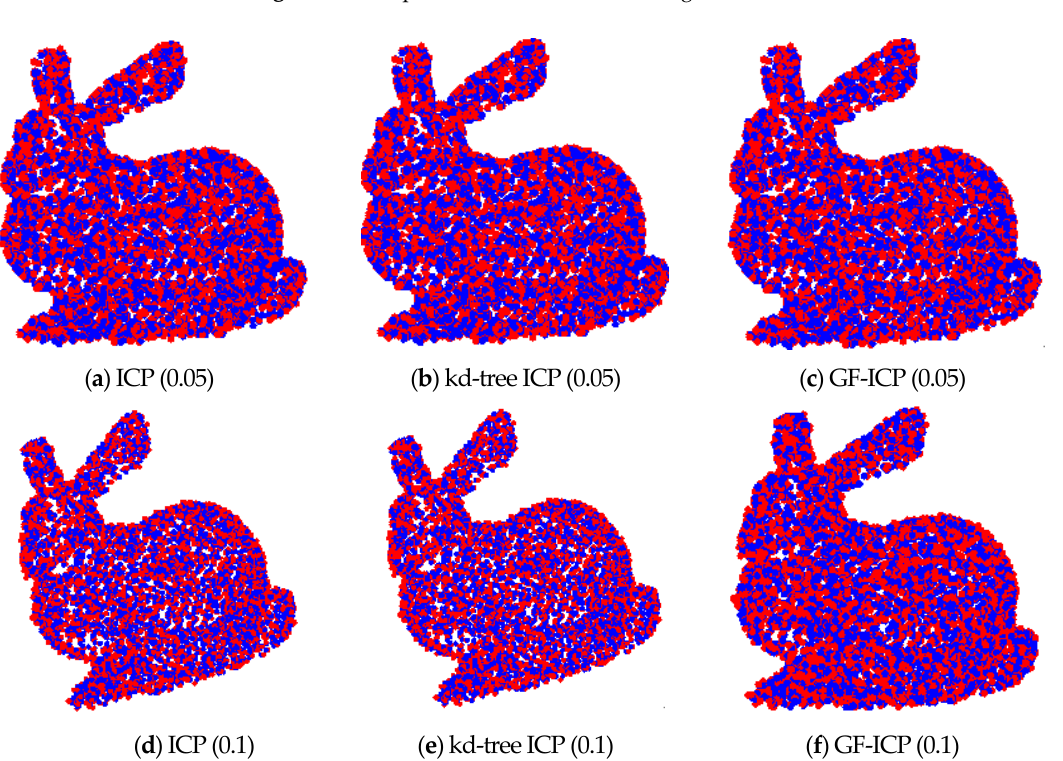
Figure 13. The point cloud registration results of the three algorithms after adding noise.